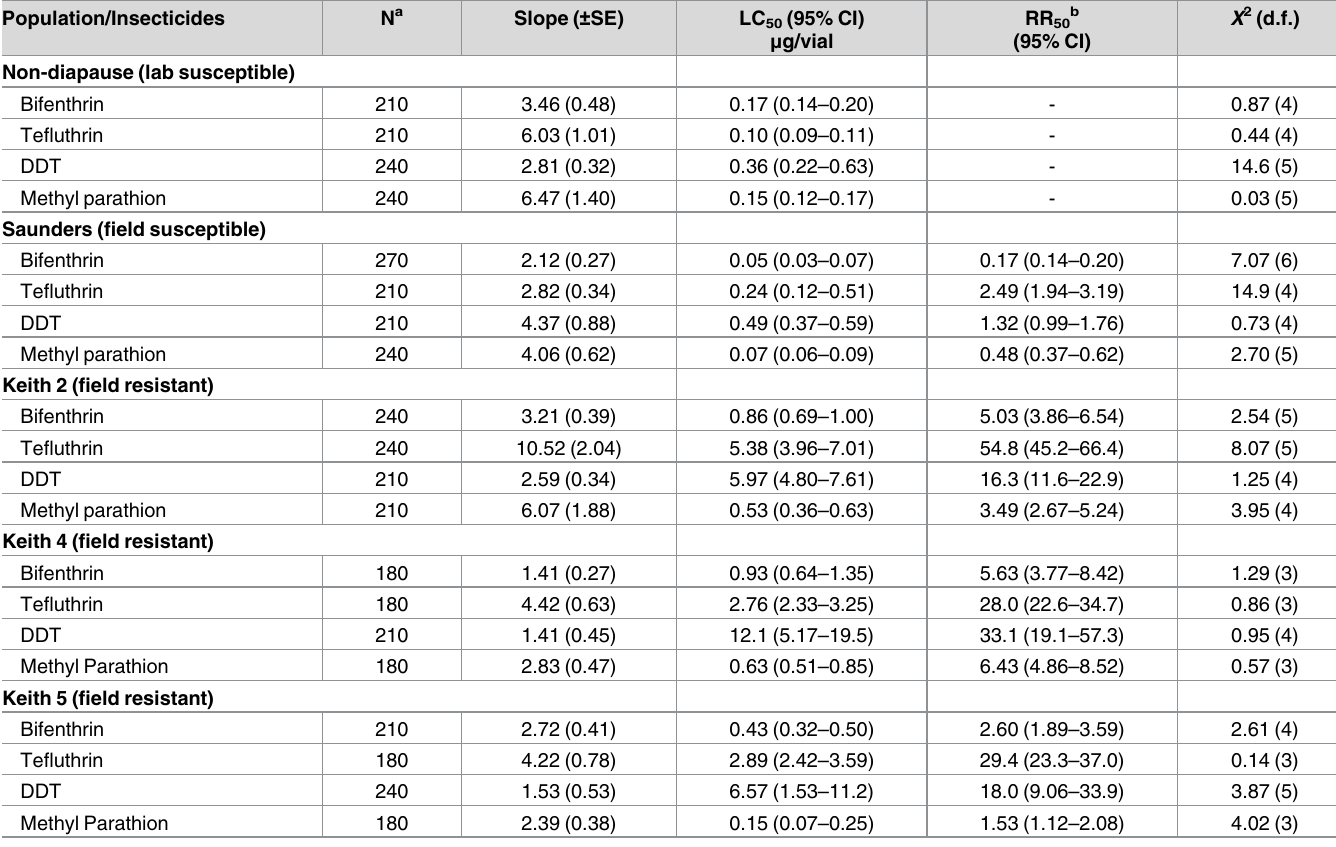
Table 2. WCR adult susceptibility and RRs to four insecticides between field populations collected in 2015 considered resistant (Keith County populations, NE) and susceptible (Saunders Co-NE), including a susceptible non-diapause population.